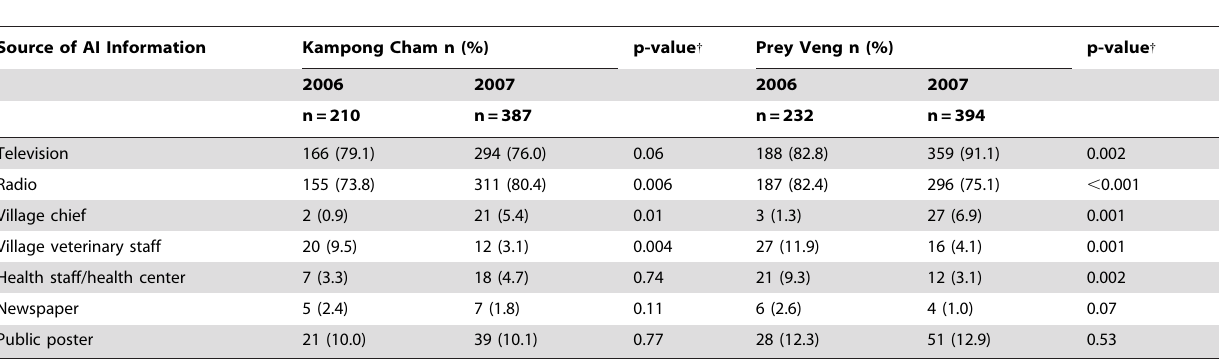
Table 2. Changes in source of avian influenza information in Kampong Cham and Prey Veng Provinces, Cambodia from January 2006 to December 2007.